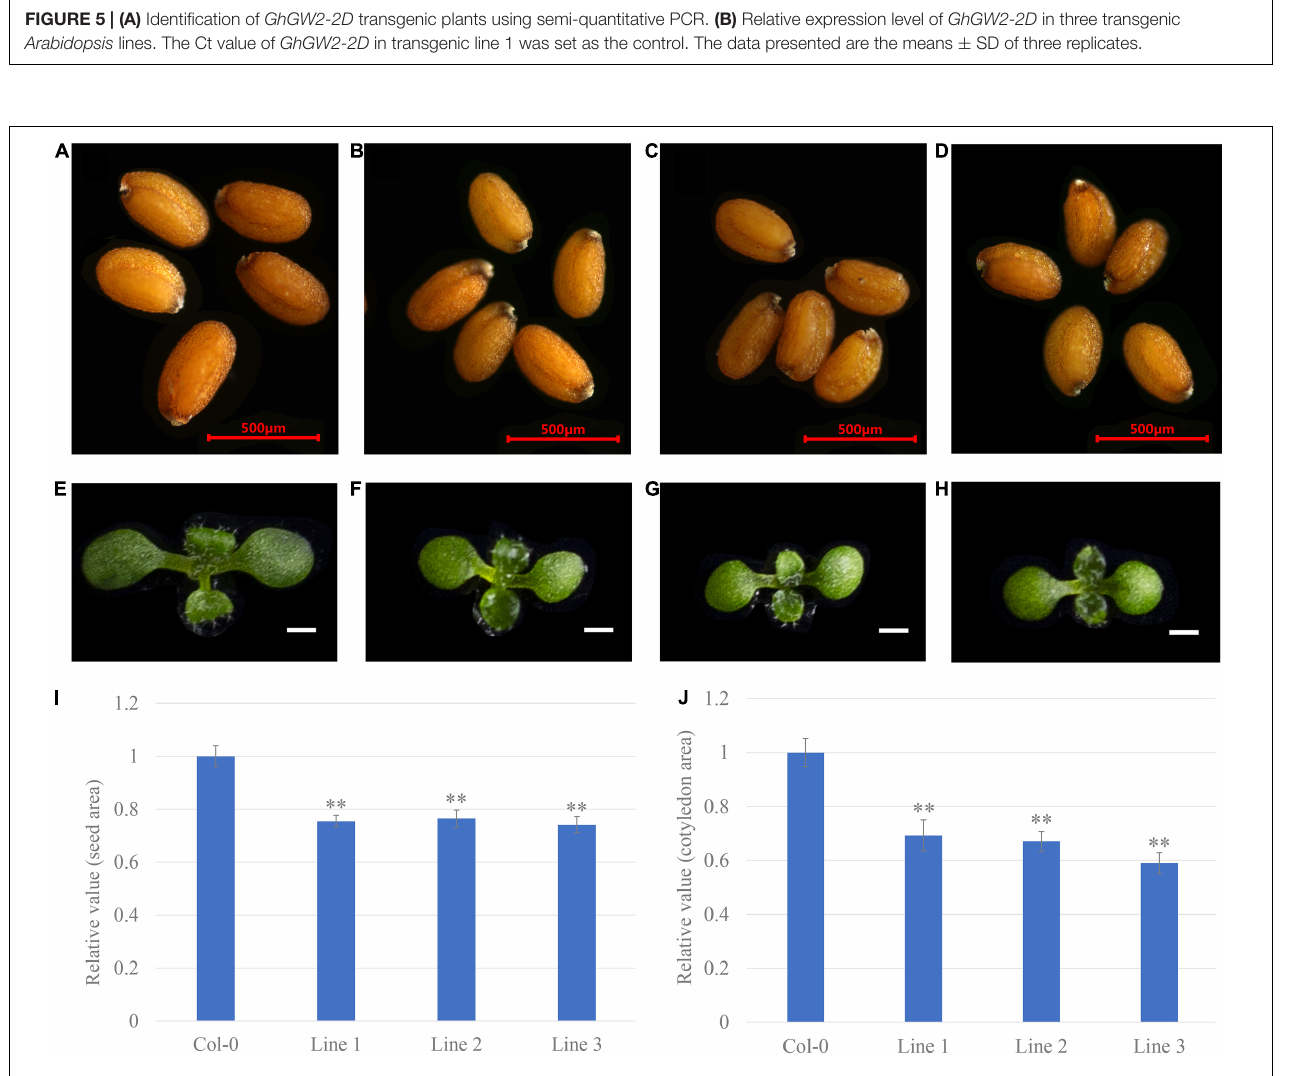
Frontiers in Plant Science |